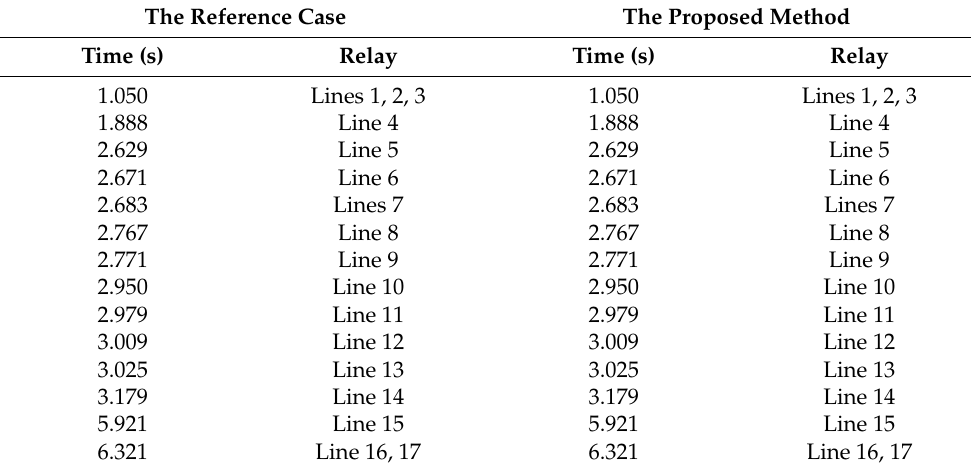
Table 5. The list of all distance relay operations in Contingency 1